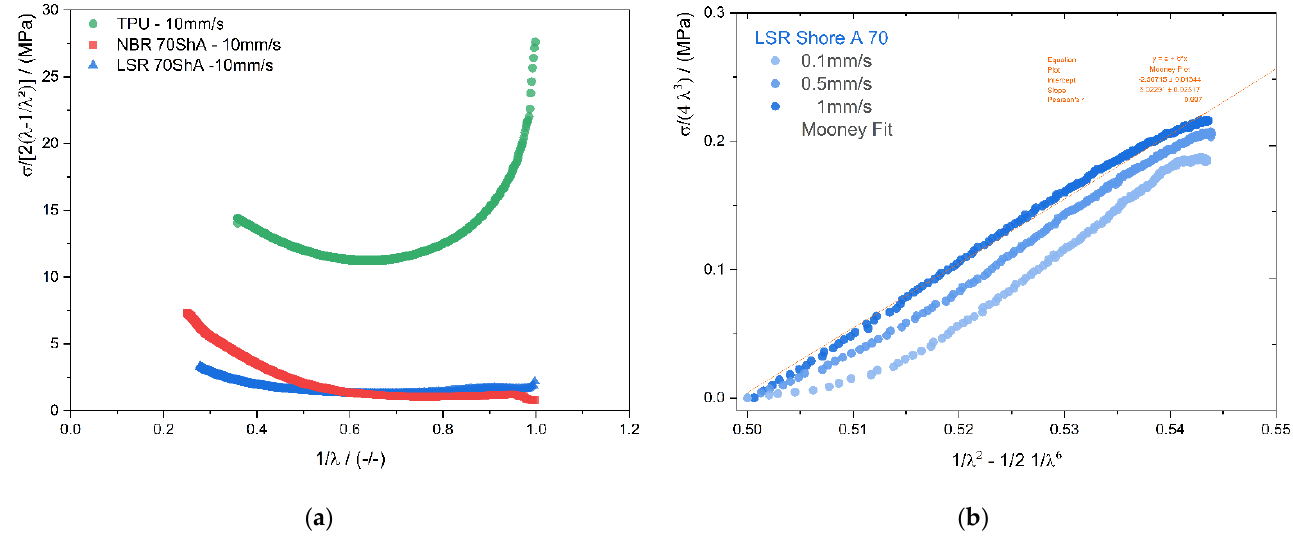
Figure 25. Hyperelastic characteristics evaluated in Mooney Plots under ( a ) uniaxial loading for all candidate materials (TPU, NBR and LSR); ( b ) equi-biaxial loading of the selected material liquid silicone rubber (LSR) with a hardness of Shore A